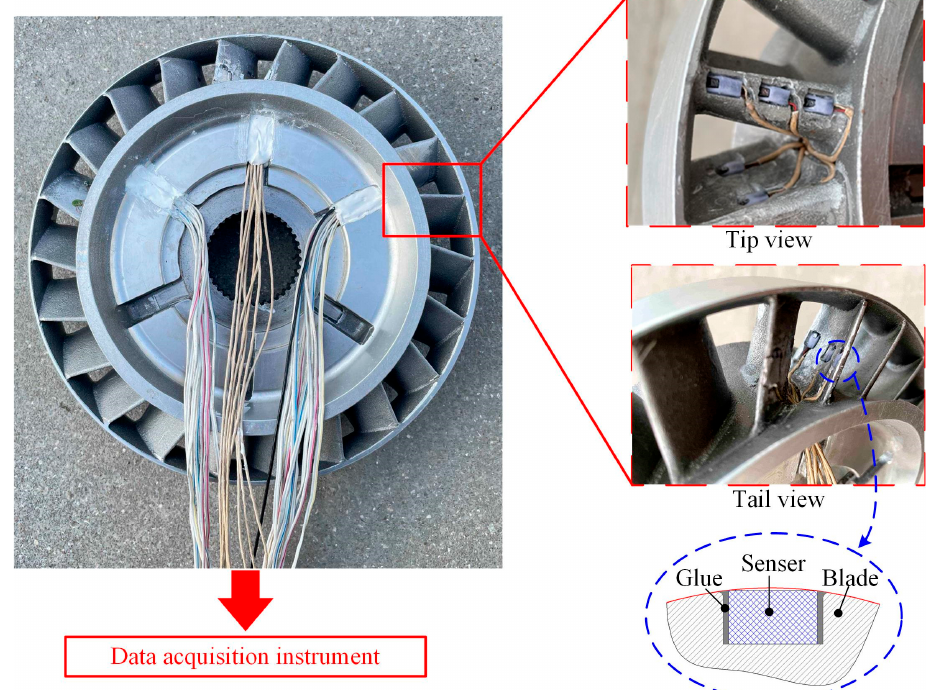
Figure 7. Stator blade surface pressure test setup.